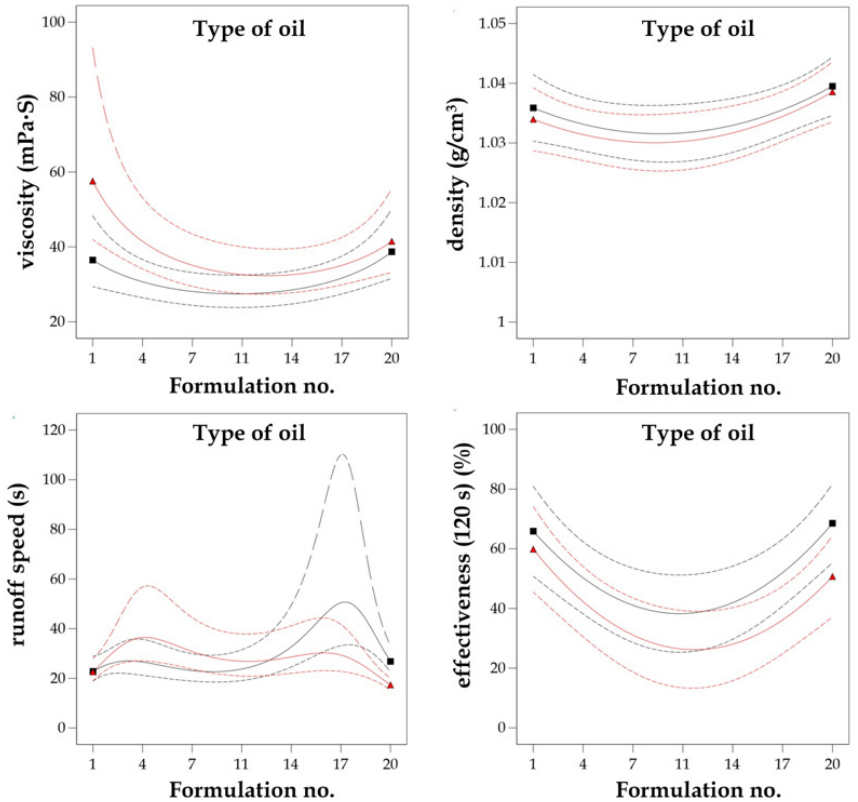
Figure 6. Interaction plots between independent variables the dependent variables (A = no. of formulation, B = type of oil) affecting the behavior of response variables (Y 1 = viscosity, Y 2 = density, Y 3 = runoff speed, and Y 4 = effectiveness (120 s)). The red line indicates sunflower oil, while black line corresponds to rapeseed oil.